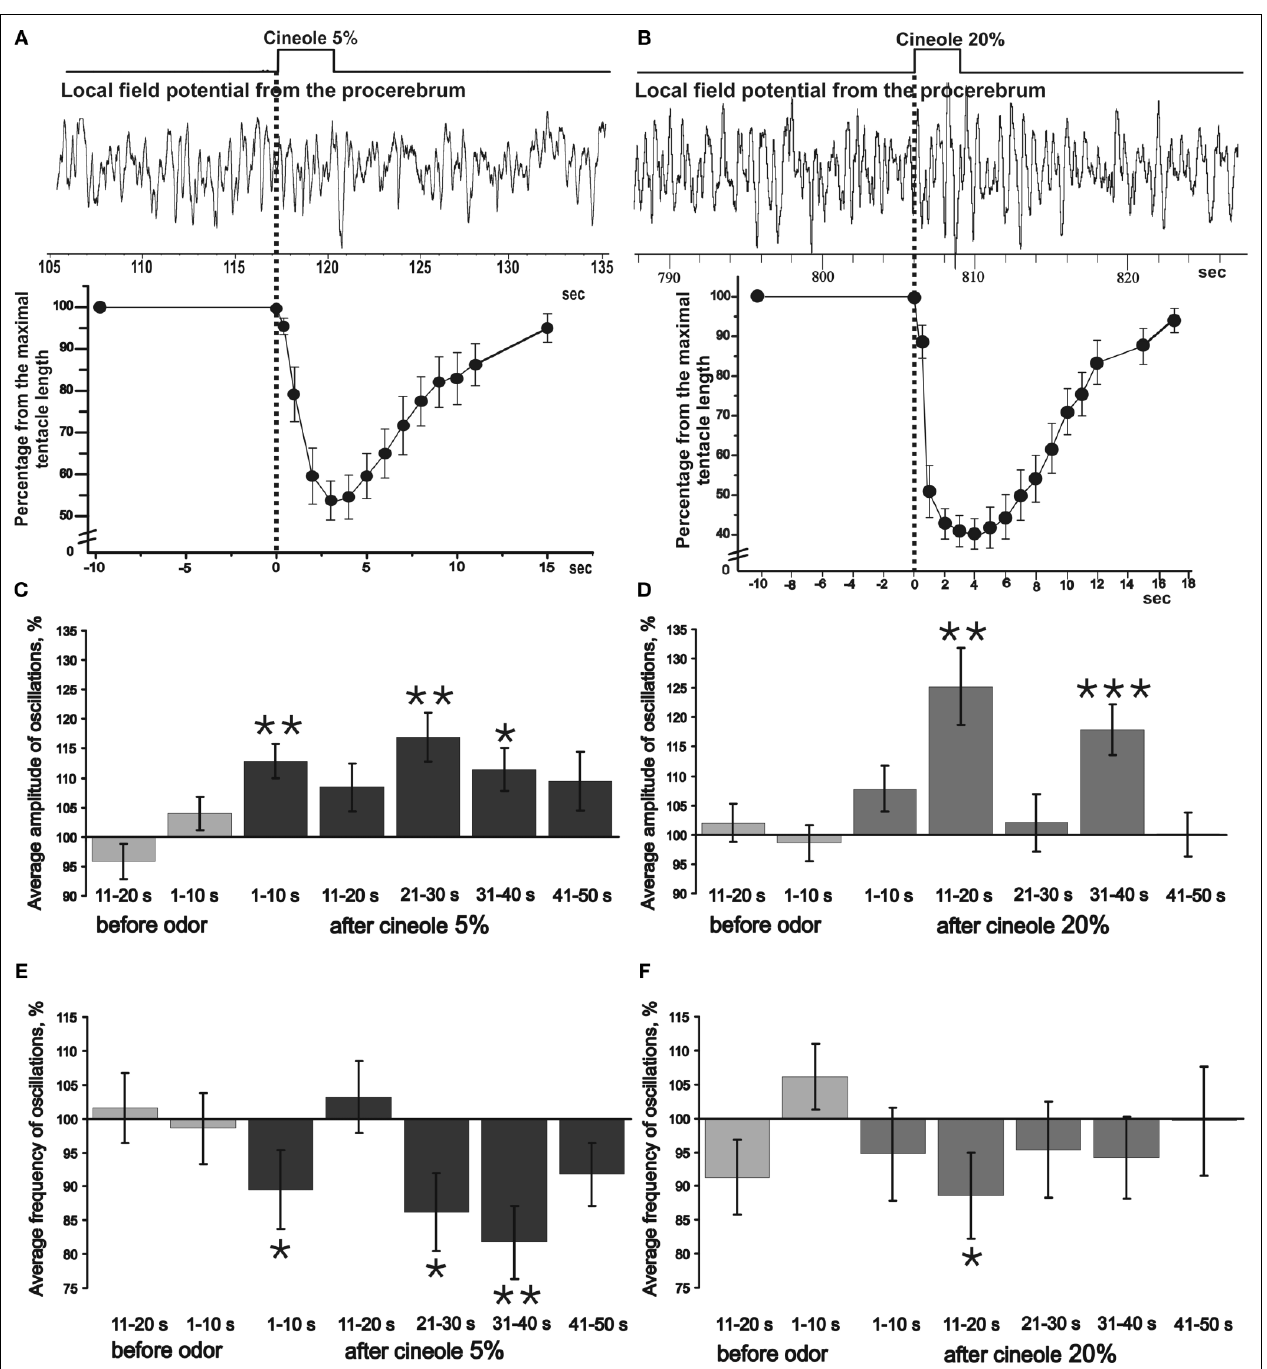
FIGURE 3 | Averaged changes in the frequency and amplitude of the procerebral oscillations in response to odor application recorded in vivo . (A) An example of extracellular recording from the procerebrum and synchronous changes in the snail’s tentacle length (summary graph based on analysis of videotaped behaviour, n = 3, four recordings from each snail are averaged) during application of the 5% cineole. Duration of the cineole application (3 s) is indicated by the step. Time scale is the same for the traces and behavioural response amplitude plot. Vertical bars indicate the standard error of the mean. (B) An example of extracellular recording from the procerebrum and synchronous changes in the snail’s tentacle length (summary graph based